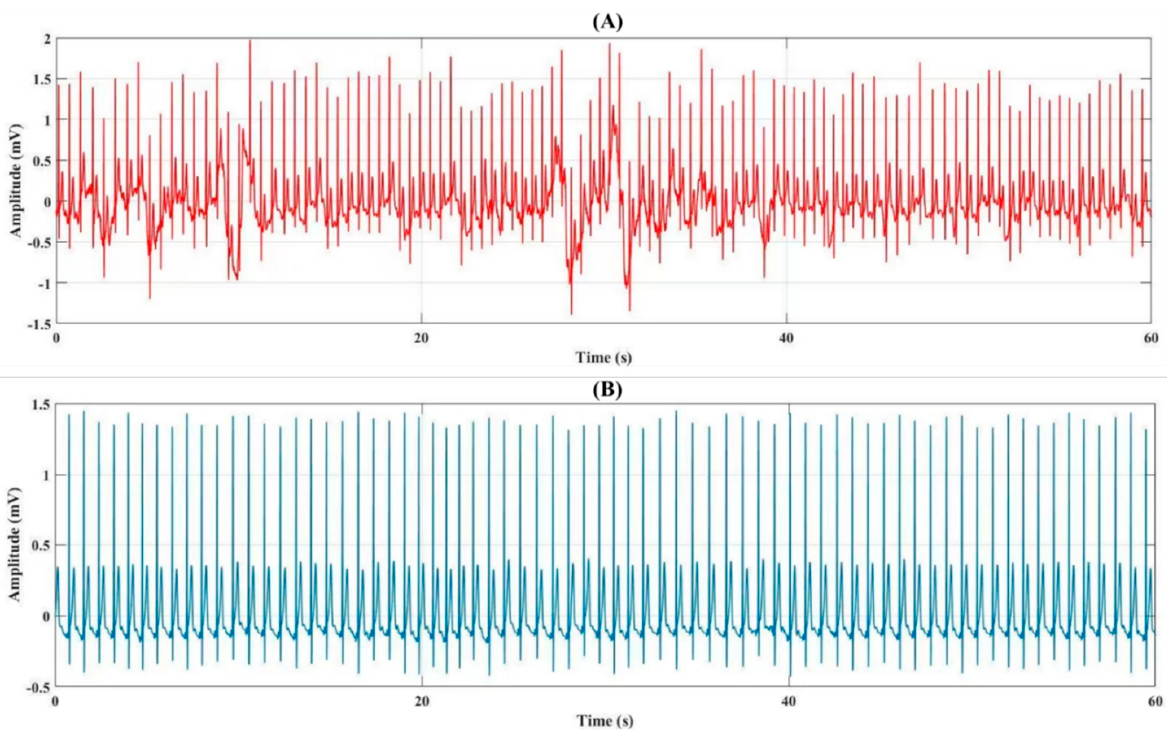
Figure 4. One minute signal representation of the single-lead raw ECG signal from (A) mental stress and (B) normal subjects.